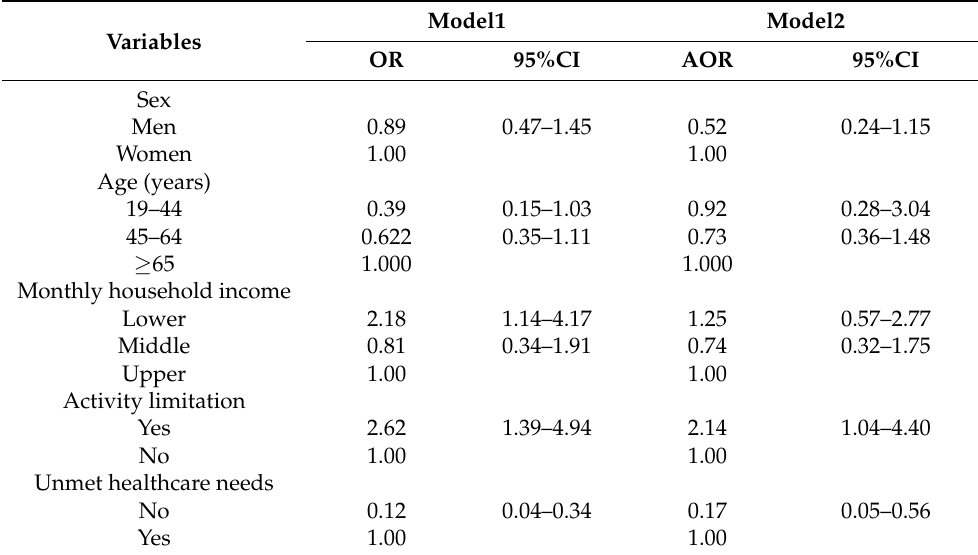
Table 3. Factors associated with unmet dental care needs among cancer